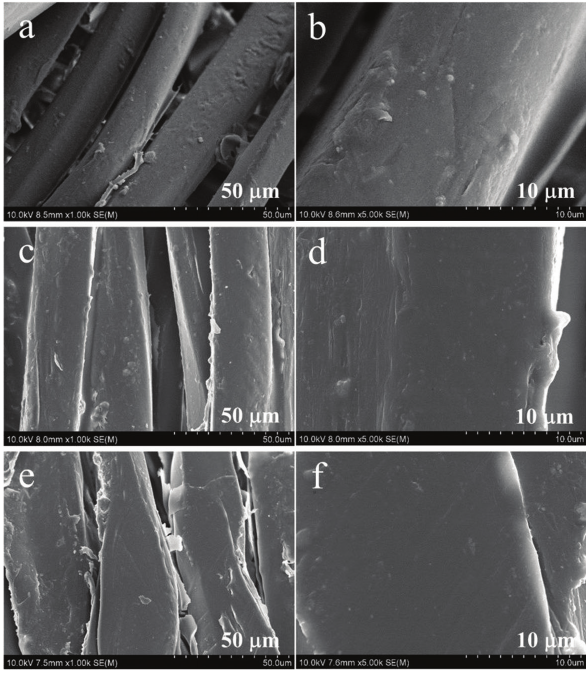
Figure 4: SEM of the PET/ZnO/TTCP/Gel woven nets with different Gel content: 1% (a,b), 5% (c,d) and 10% (e,f).